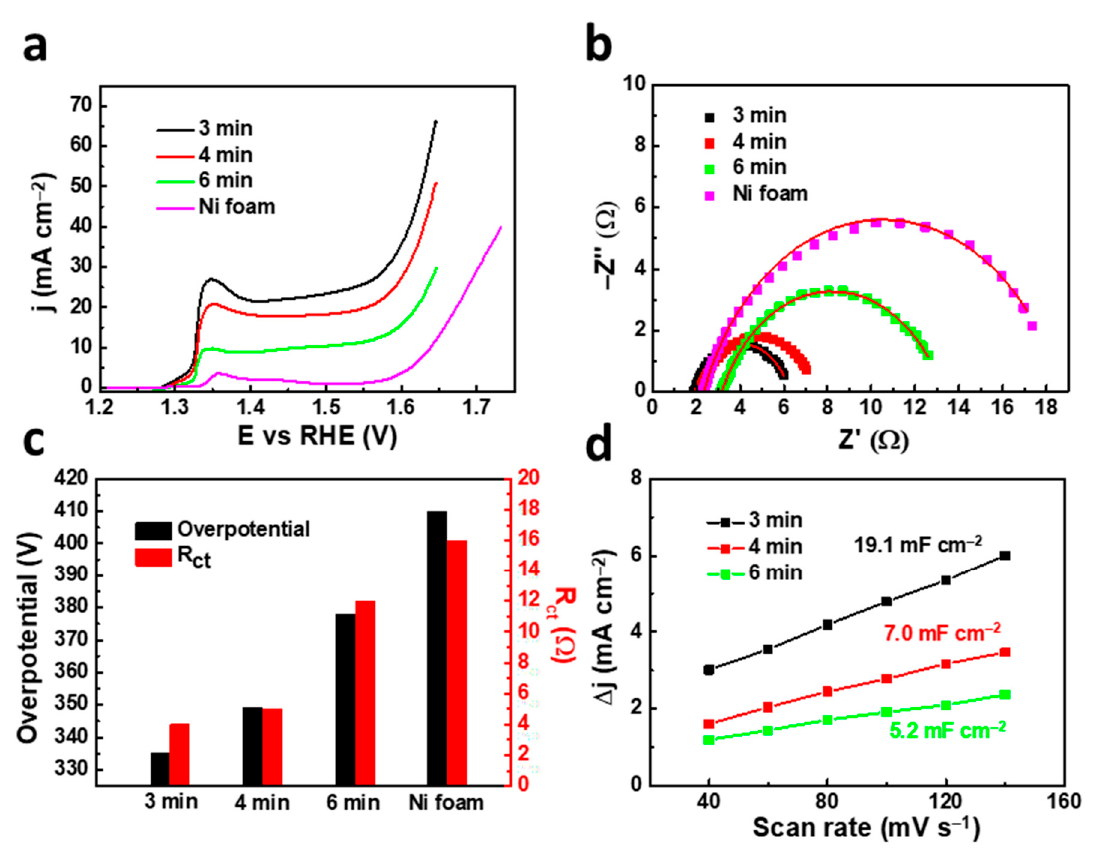
Figure 5. ( a ) Polarization curves of Ni foam and Ni–P 24 coatings deposited on Ni foam at different times; ( b ) Nyquist plots of the four samples with the fitting curves plotted; ( c ) comparison of overpotential and charge transfer resistance among the four samples; ( d ) the difference between the anodic and cathodic current densities ( Δ J = − J a − J c ) plotted against the scan rate for catalysts deposited at different times.